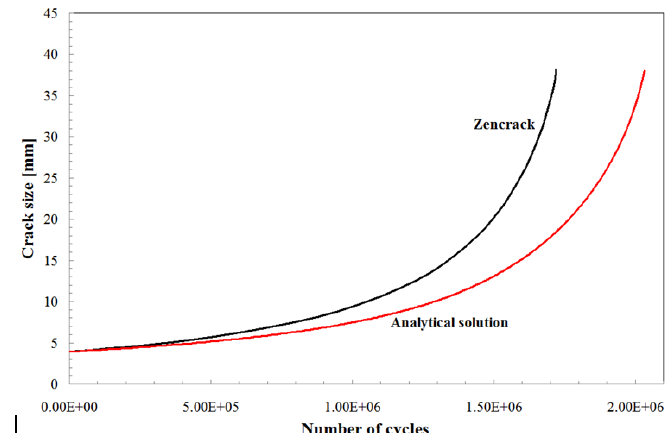
Figure 9: Comparison between analytical and FE residual life estimation for initial crack length 3.92